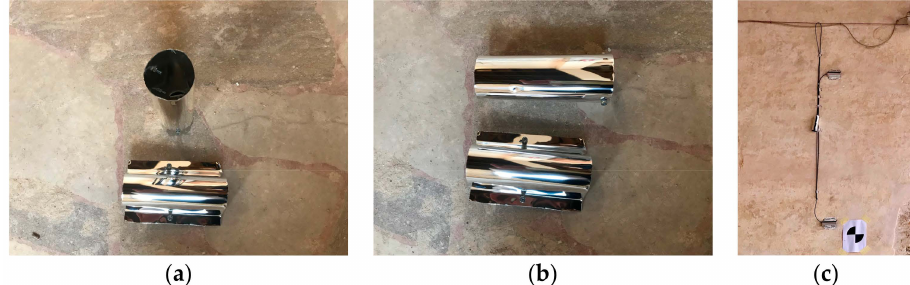
Figure 8. Metallic screen to protect external sensors from environmental conditions ( a ); ( b ) metallic screen; ( c ) application of the screen on the wall (photos by E.